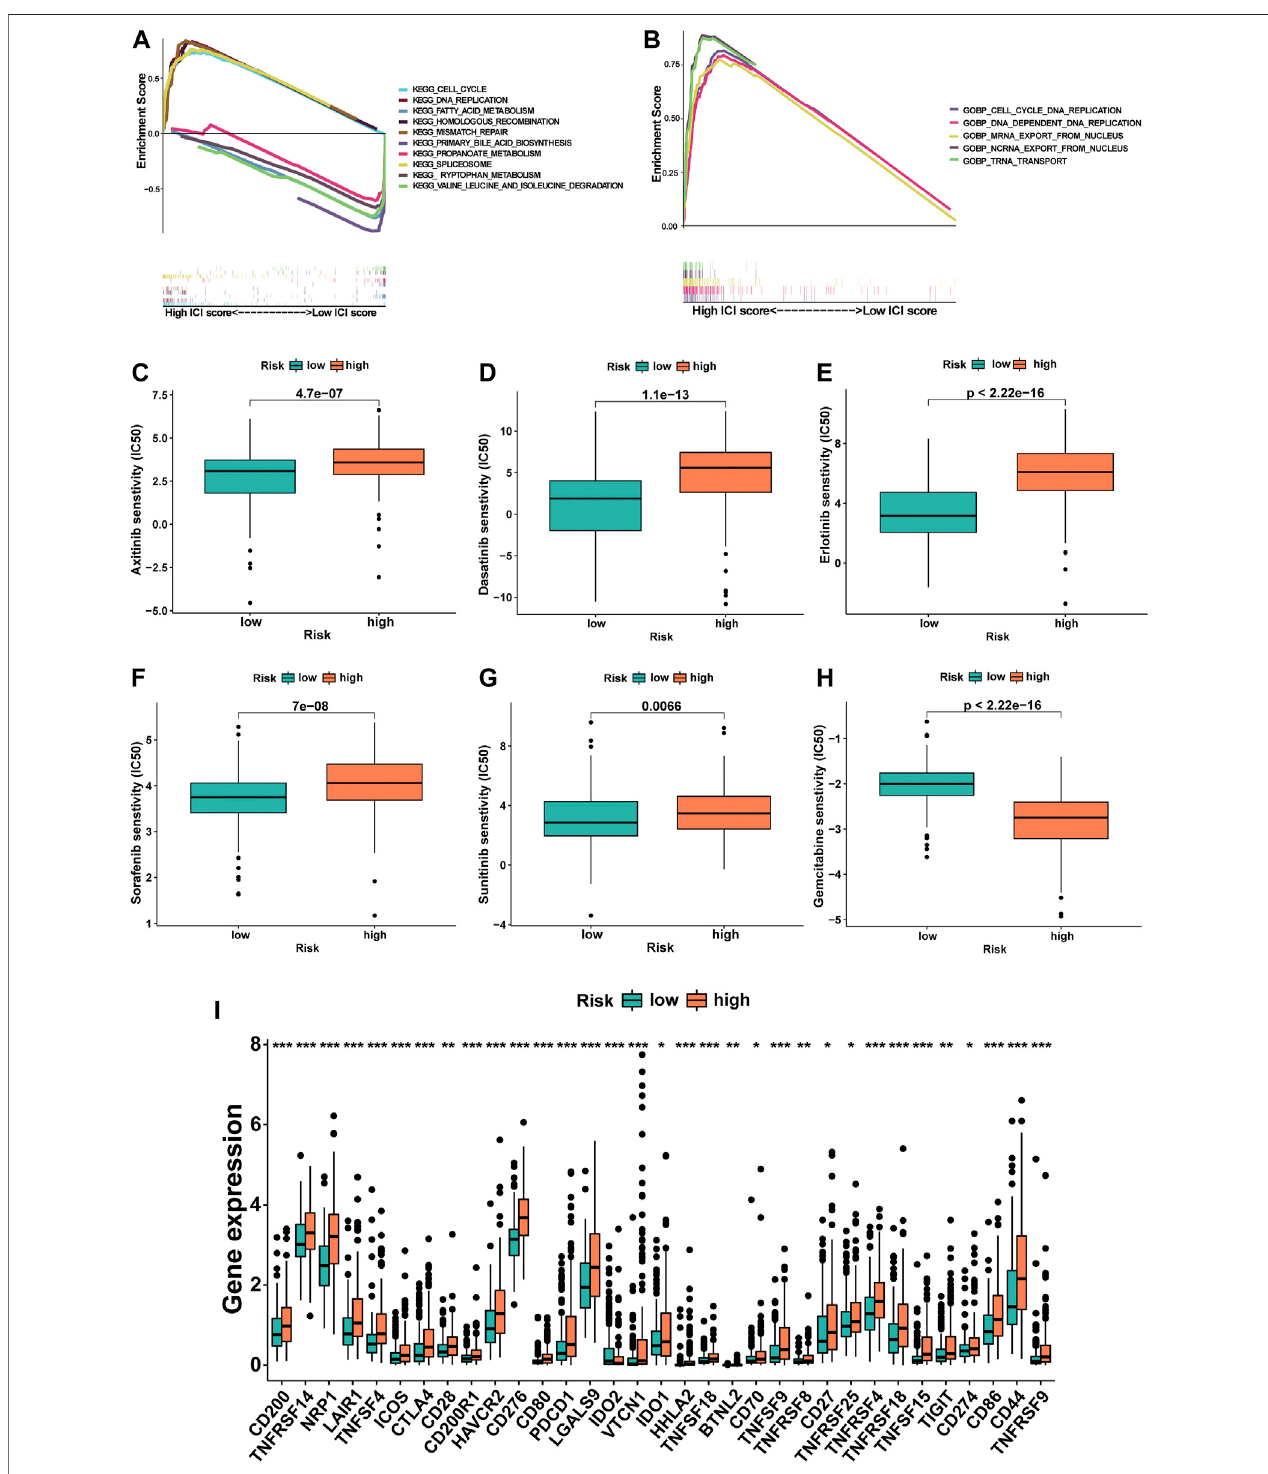
FIGURE 10 | The potential mechanism of m6A-9LPS in TCGA cohort was studied by gene set enrichment analysis. (A) Five representative pathways in the high- riskgroup and fi verepresentative pathways inthelow-riskgroup byKEGG enrichment analysis. (B) Five representativebiologicalprocesses in thehigh-risk groupofBP by GO enrichment analysis. The difference of IC50 of axitinib (C) , dasatinib (D) , erlotinib (E) , sorafenib (F) , sunitinib (G) , and gemcitabine (H) between high- and low-risk groups. Box plot of 33 immune checkpoints in entire cohort (green: low-risk group, red: high-risk group; p -values were: *** p < 0.001, ** p < 0.01, * p < 0.05) (I) .